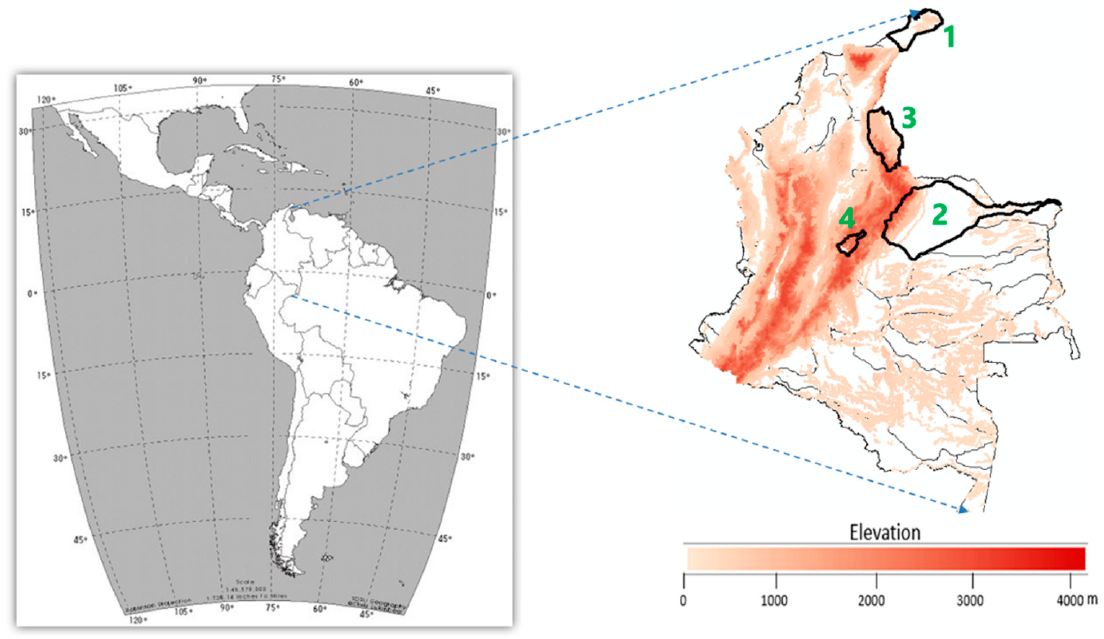
Figure 1. Location of the studied areas with elevation.